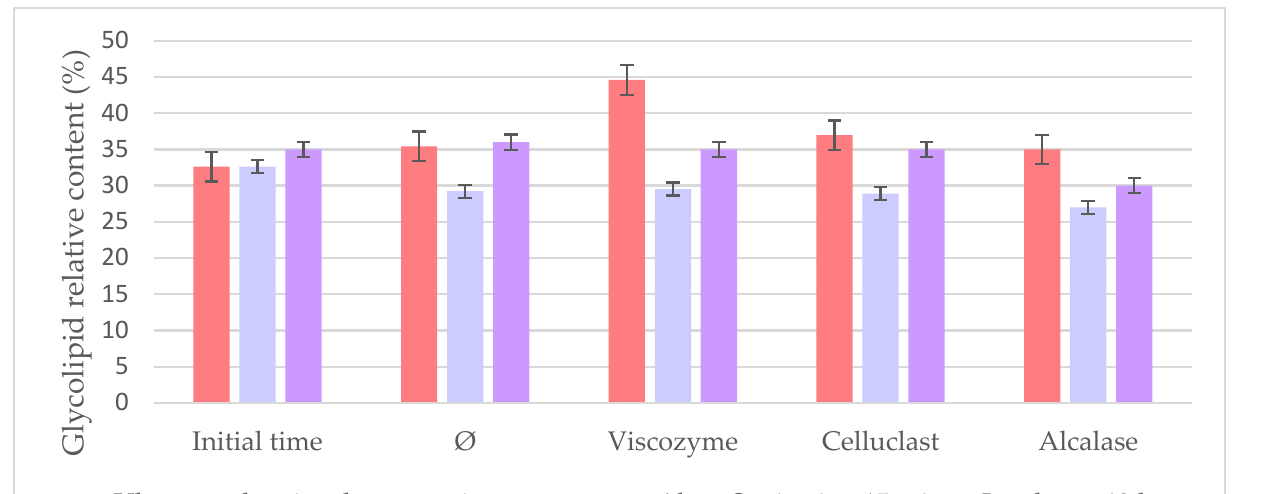
Figure 7. Glycolipid relative content (%) of Nannochloropsis extracts obtained using different pretreatment methods.